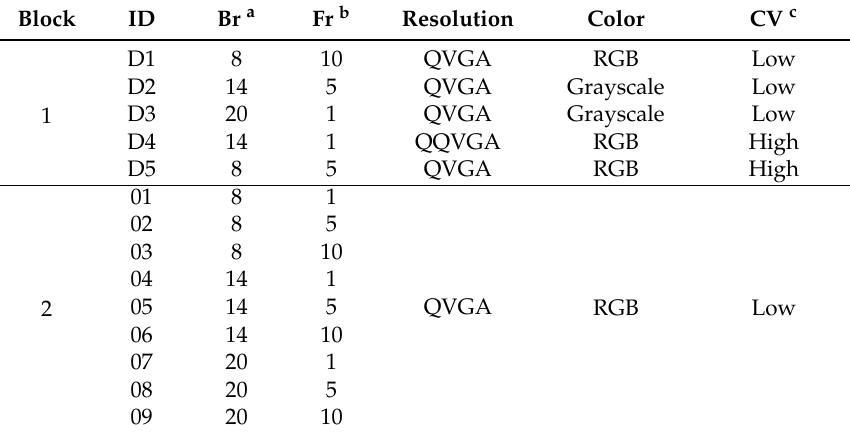
Table 2. Evaluation